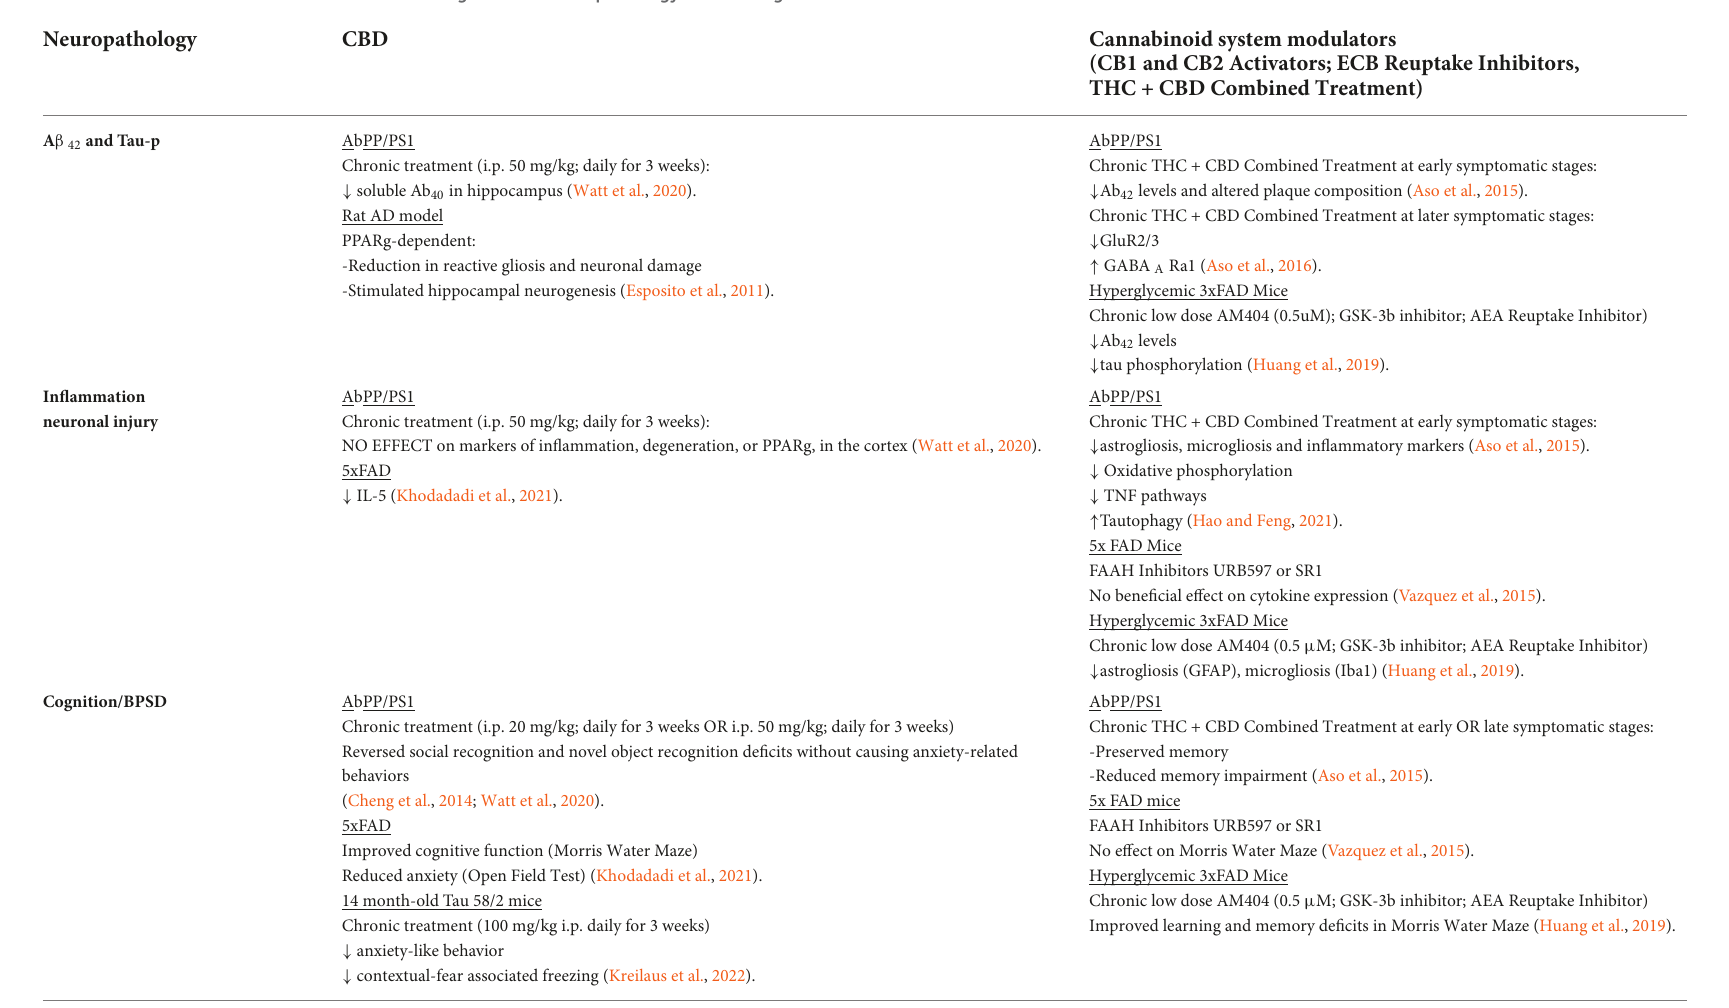
TABLE 2 Influence of CBD/THC or non-selective agonists on neuropathology in AD transgenic rodent